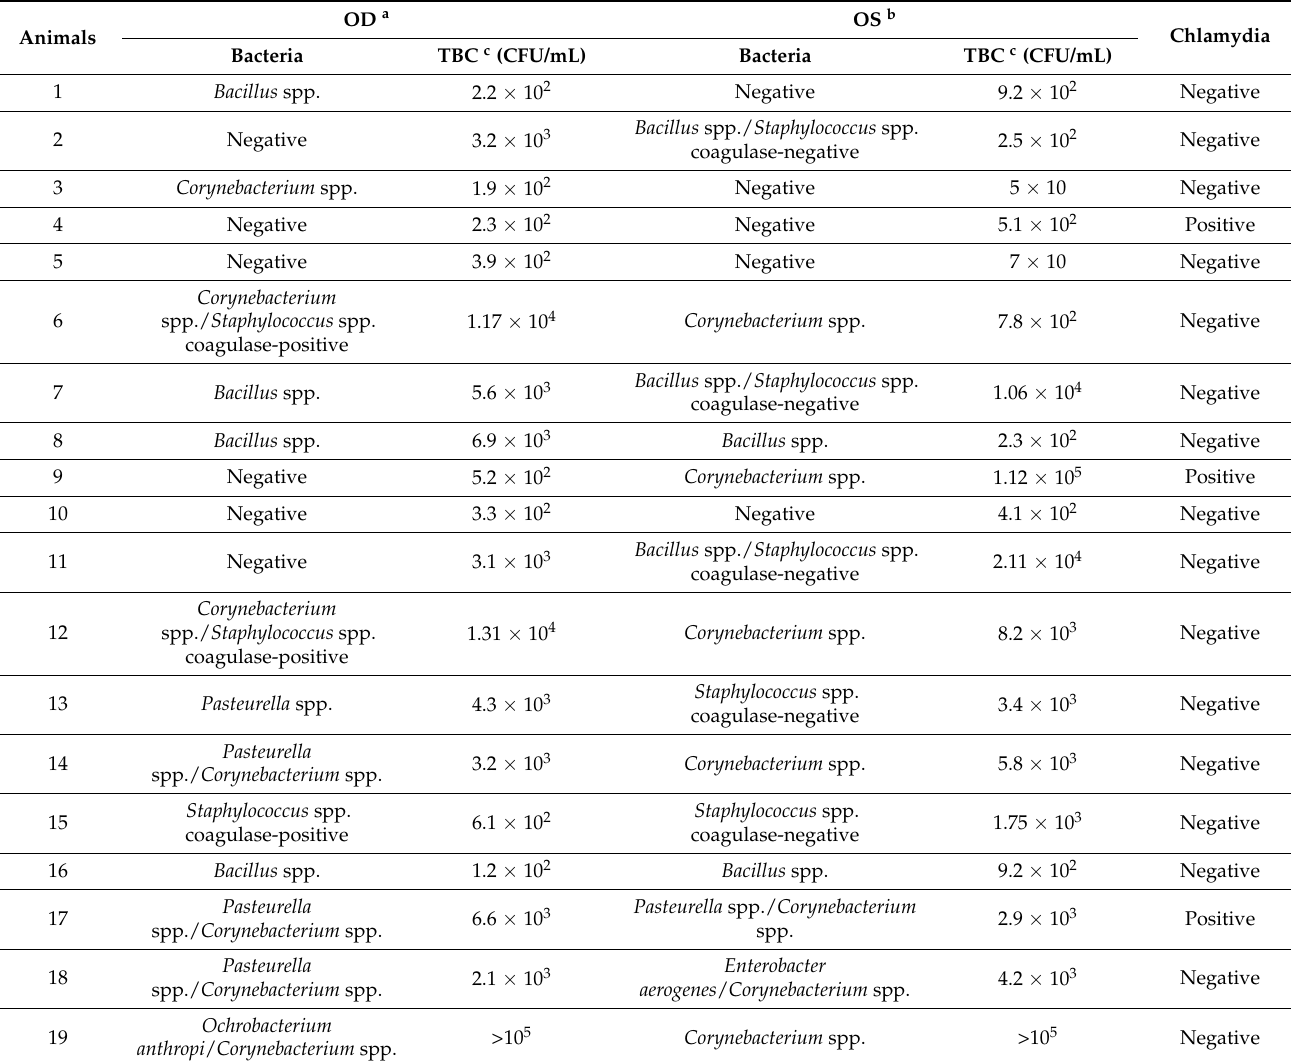
Table 4. Conjunctival bacterial flora